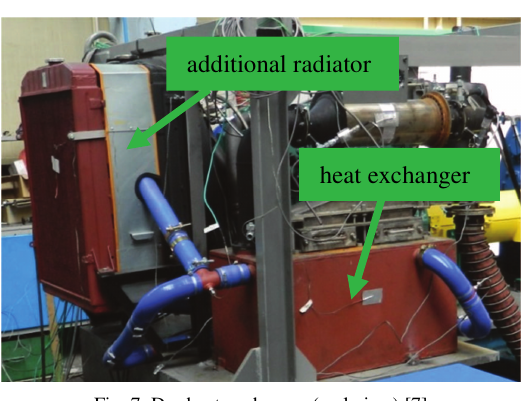
Fig. 6. Dry heat exchanger (model) [7]